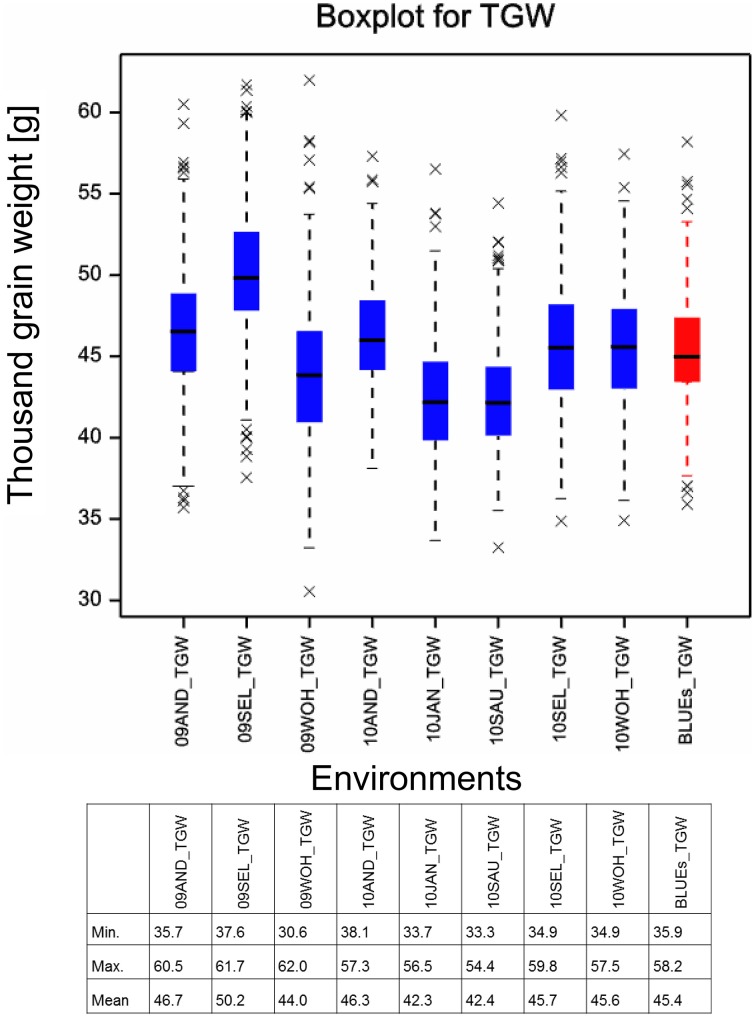
Boxplot for thousand grain weight. Boxplots for the eight field environments are depicted in blue, the BLUEs is shown in red. Asterisks mark outlier varieties. The table below indicates the minimal, maximal and mean TGW values measured in the single environments and estimated for the BLUEs.